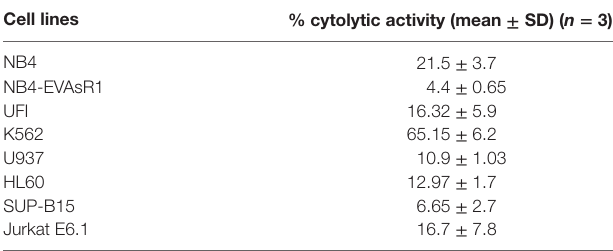
TaBle 1 | The percentage cytolytic activity of NK92MI cell line toward different leukemic cell lines at the E:T ratio of 10:1 assessed by CFSE/7AAD cytotoxicity assay.